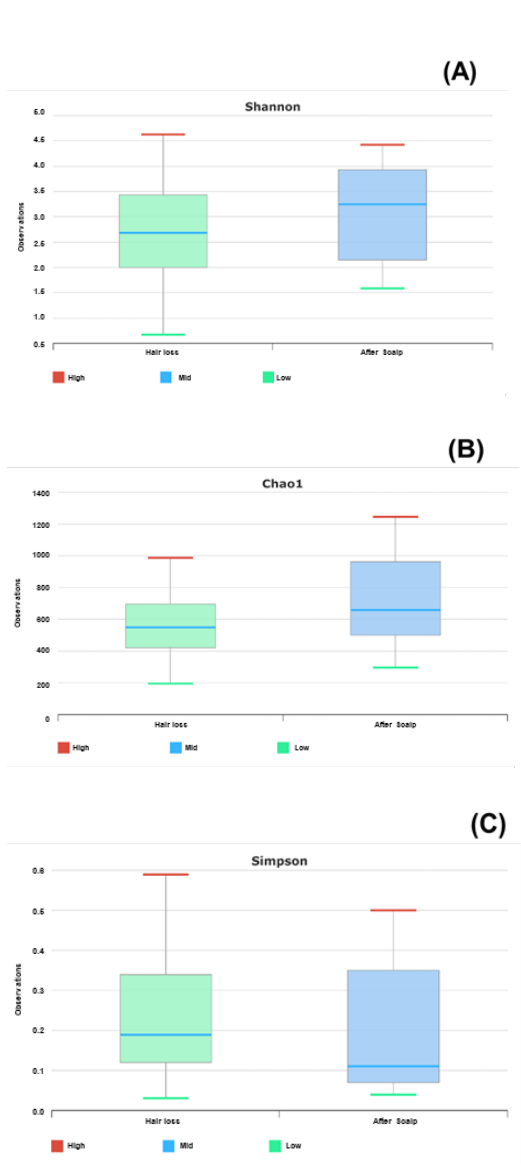
Figure 4. Species diversity ( A ), abundance ( B ), and uniformity ( C ) indices before/after the clinical trial of Cicaria supernatant shampoo clinical trial .